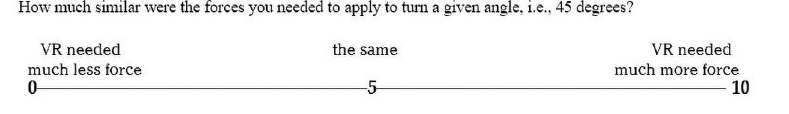
Up to 0.1 Response time or interactivity (for VR_sysII)